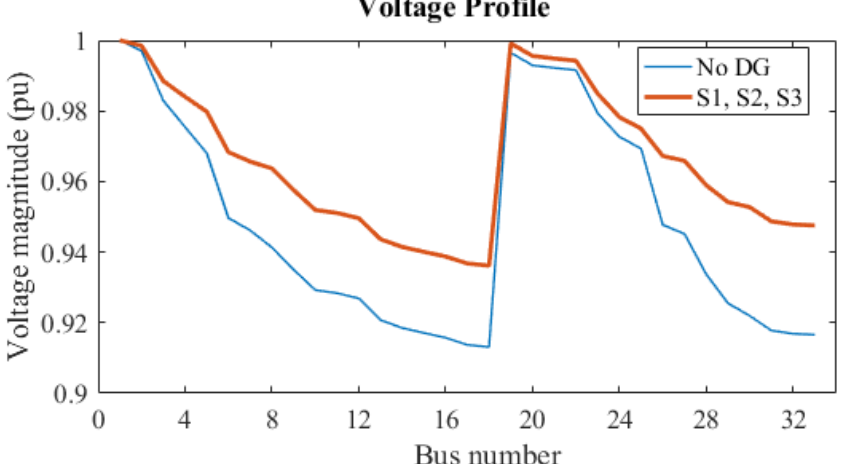
Figure 10. Voltage magnitude at each